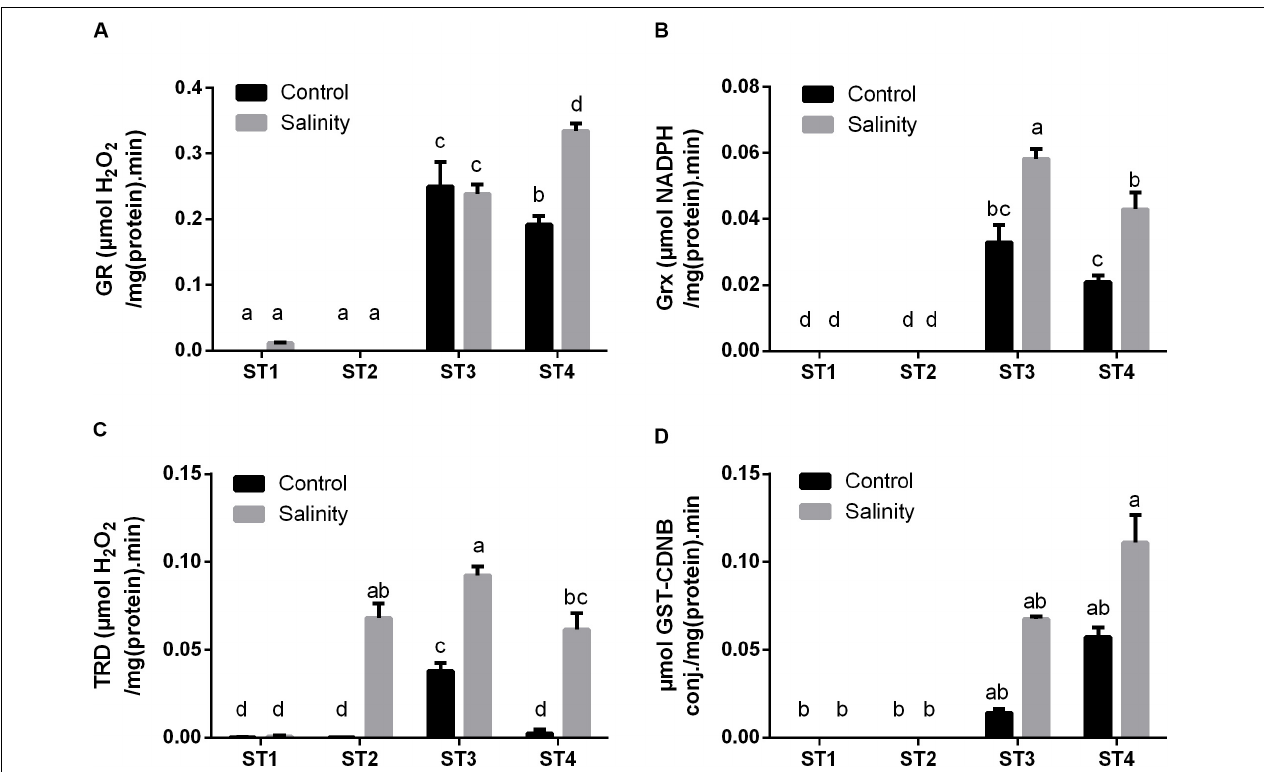
FIGURE 7 | The antioxidant enzyme activities that have reducing activities to the antioxidant metabolites of four salt-tolerant bacterial isolates (ST1, ST2, ST3, and ST4) including (A) GR, (B) Grx, and (C) TRD, as well as the detoxification enzyme (D) GST activity under control and salinity stress conditions. Data are represented by the mean of at least three replicates, and error bars represent the standard error. Different small letters (a, b, c ... ) above bars indicate significant differences between means at p <